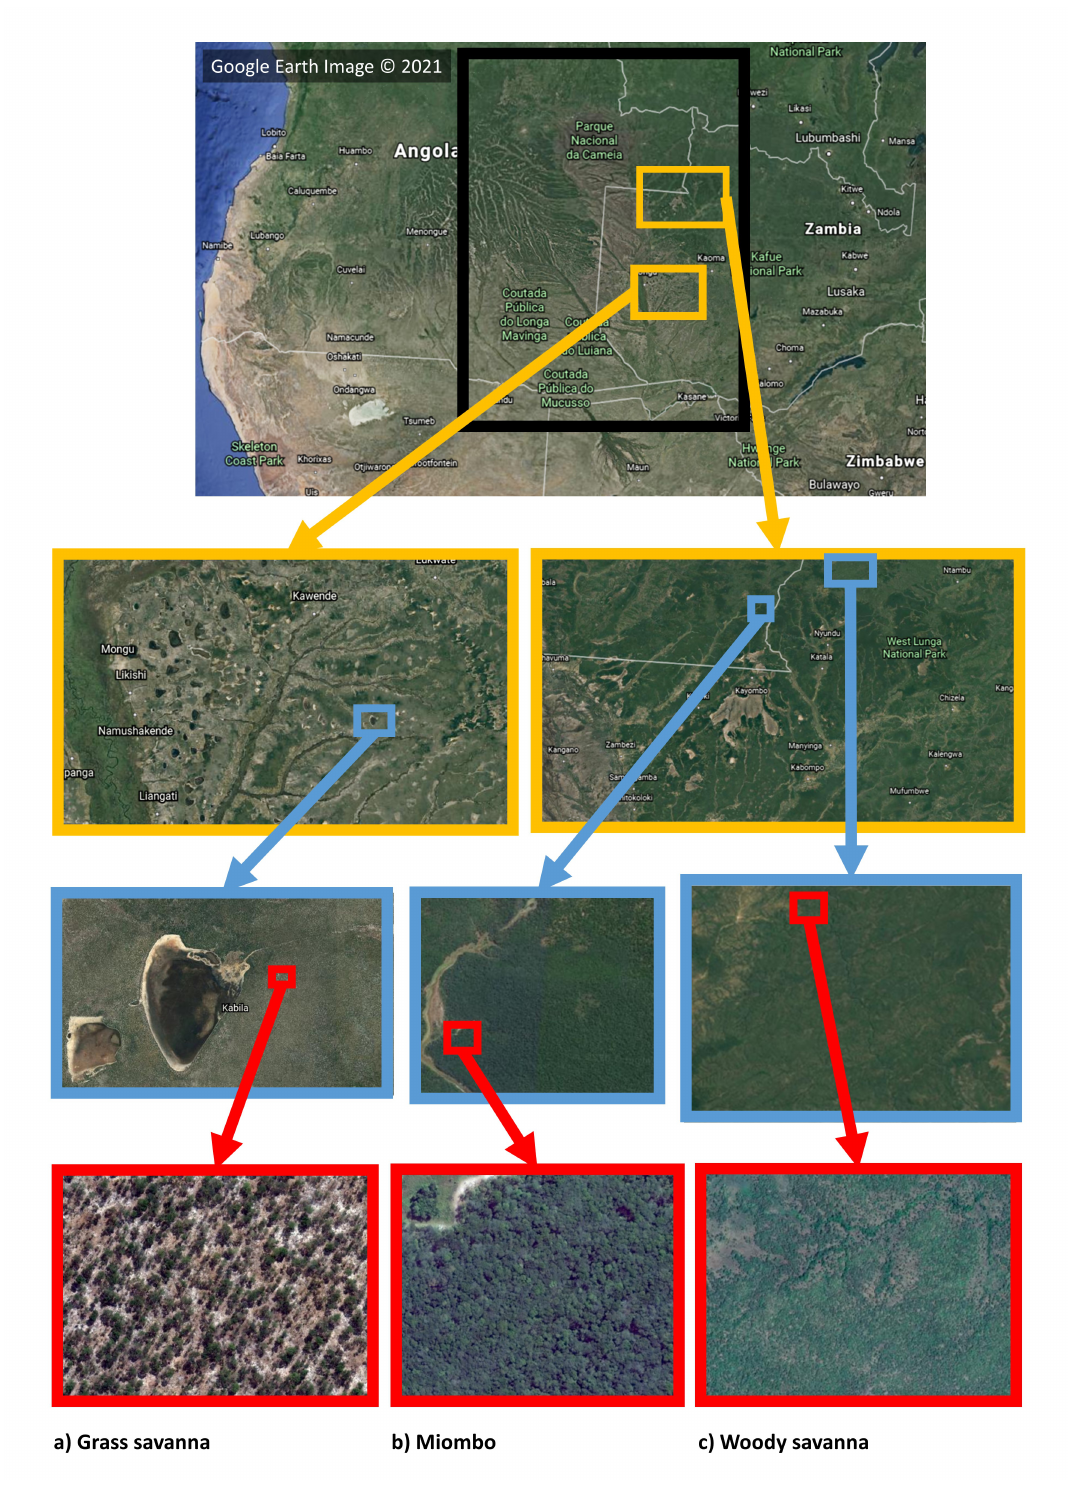
Figure 5. Google Earth images comparing vegetation densities of three different land cover types in the UZRB: ( a ) grass savanna; ( b ) miombo; ( c ) woody savanna [81]. Google Earth Image ©2021: Google, Data SIO, National Oceanic and Atmospheric Administration (NOAA), U.S. Navy, National Geospatial-Intelligence Agency (NGA), General Bathymetric Chart of the Oceans (GEBCO), Landsat/Copernicus, AfriGIS (Pty) Ltd, International Bathymetric Chart of the Arctic Ocean (IBCAO), Maxar Technologies, Centre National D’Etudes Spatiales (CNES; National Centre for Space